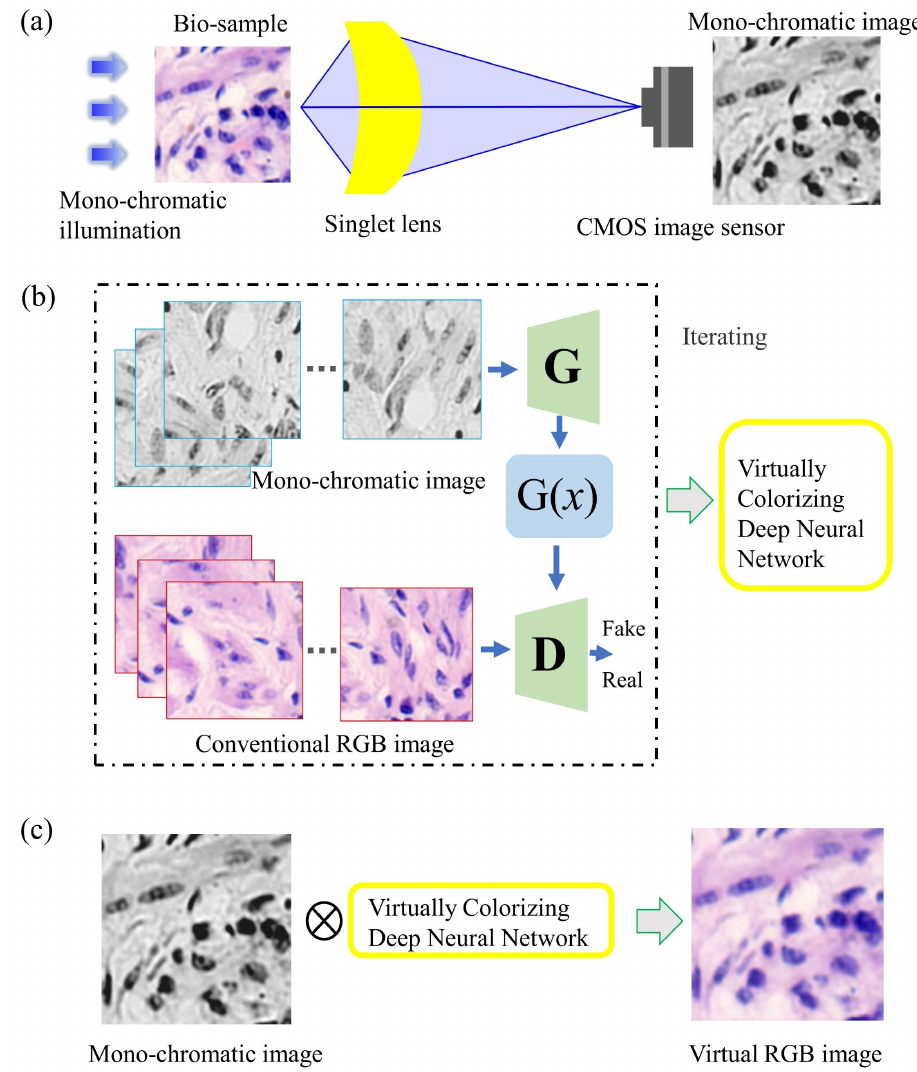
Figure 14. Singlet achromatic microscopy based on deep learning virtual colorization [106]. ( a ) 2D schematic; ( b ) a deep learning virtualizing flowchart; and ( c ) an application working flowchart.